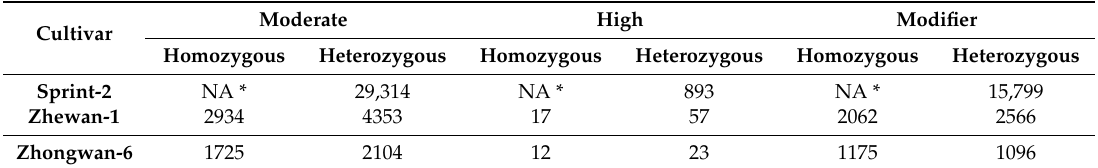
Table 2. Distribution of single nucleotide polymorphisms in three pea